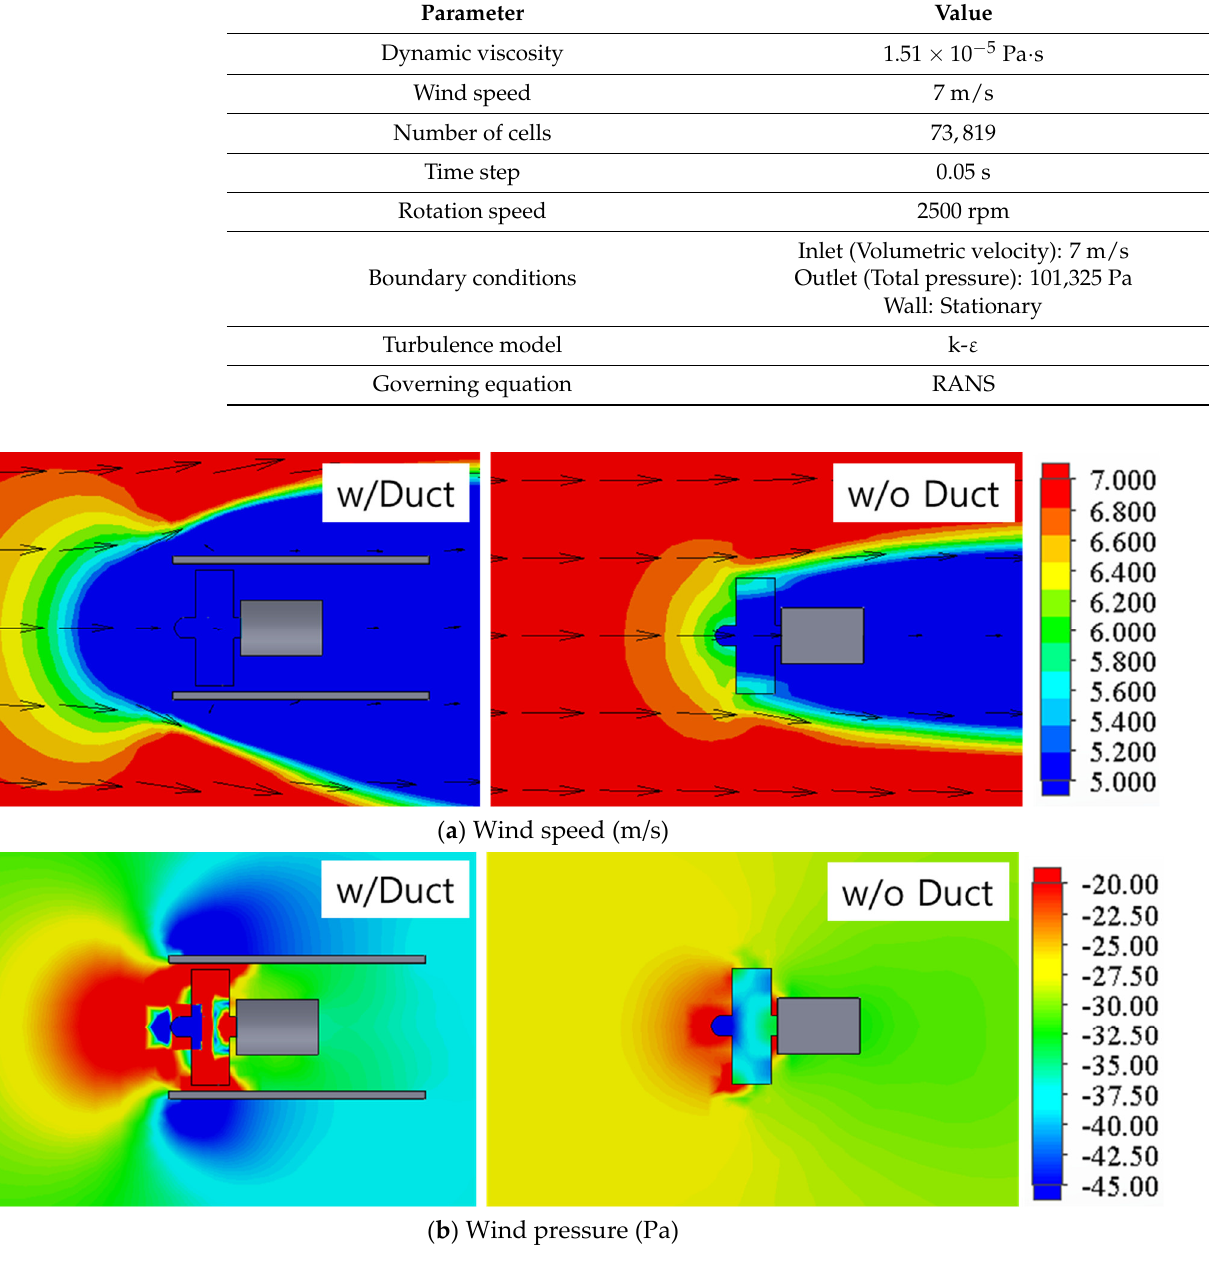
Figure 2. Comparison of wind speed and pressure according to the presence or absence of ducts.